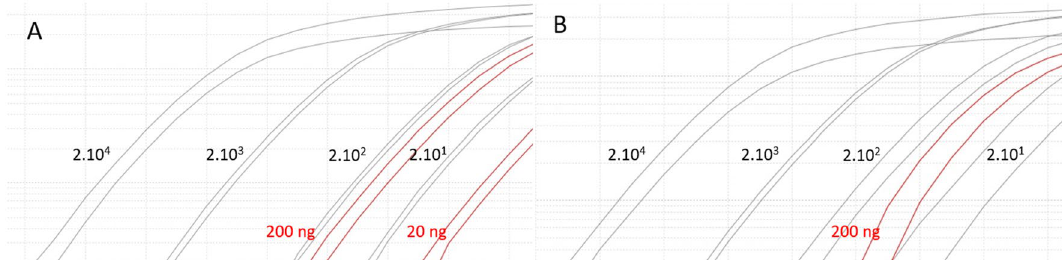
Figure 7. Real-time PCR amplification for quantifiable control and detection curves. Four different concentrations of quantification control for SARS-CoV-2 (iDT—INTEGRATED DNA TECHNOLOGIES, IOWA, USA) using the hCOVassay1 ( A ) and hCOVassay2 ( B ) primer sets are represented in grey curves. The different sample concentrations (total ssDNA after extraction) from positive patient are represented in red curves.